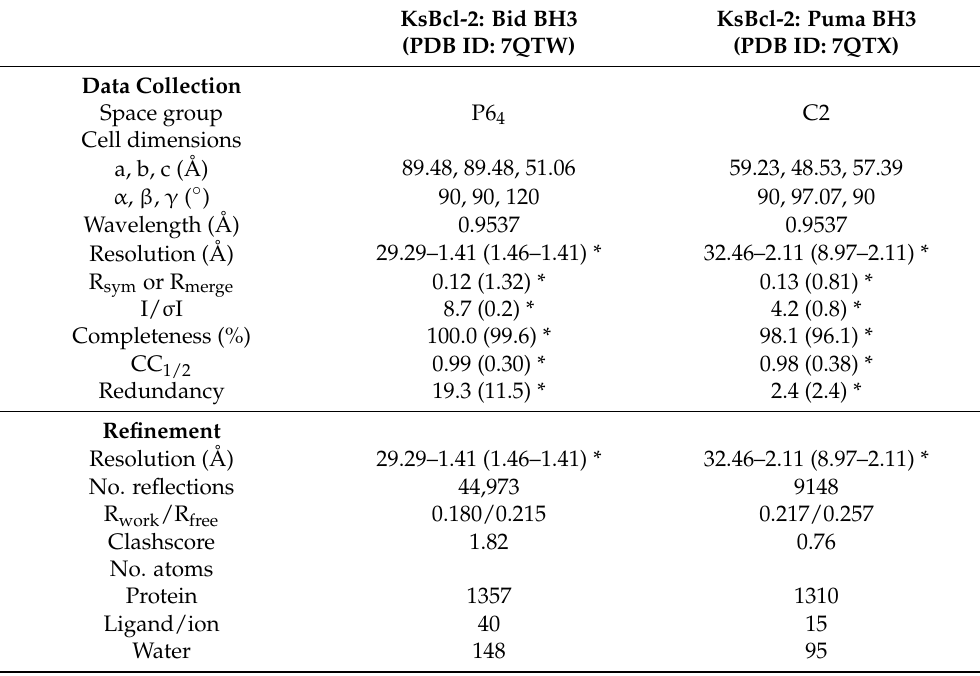
Table 2. X-ray diffraction data collection and refinement